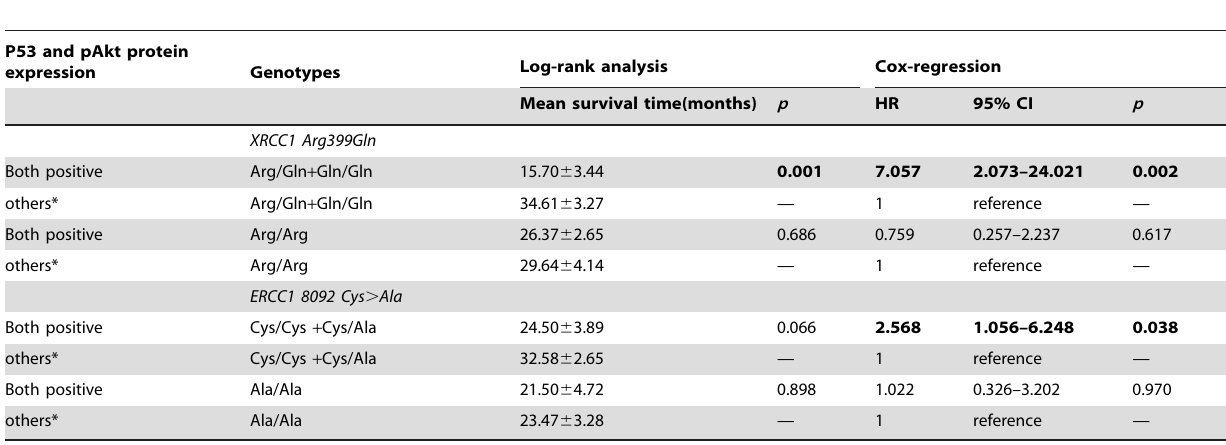
Table 3. Log-rank and proportional hazard analysis (Cox method) for progression-free survival (PFS) related to p53 and pAkt protein expression affected by polymorphism of XRCC1 Arg399Gln and ERCC1 8092Cys .